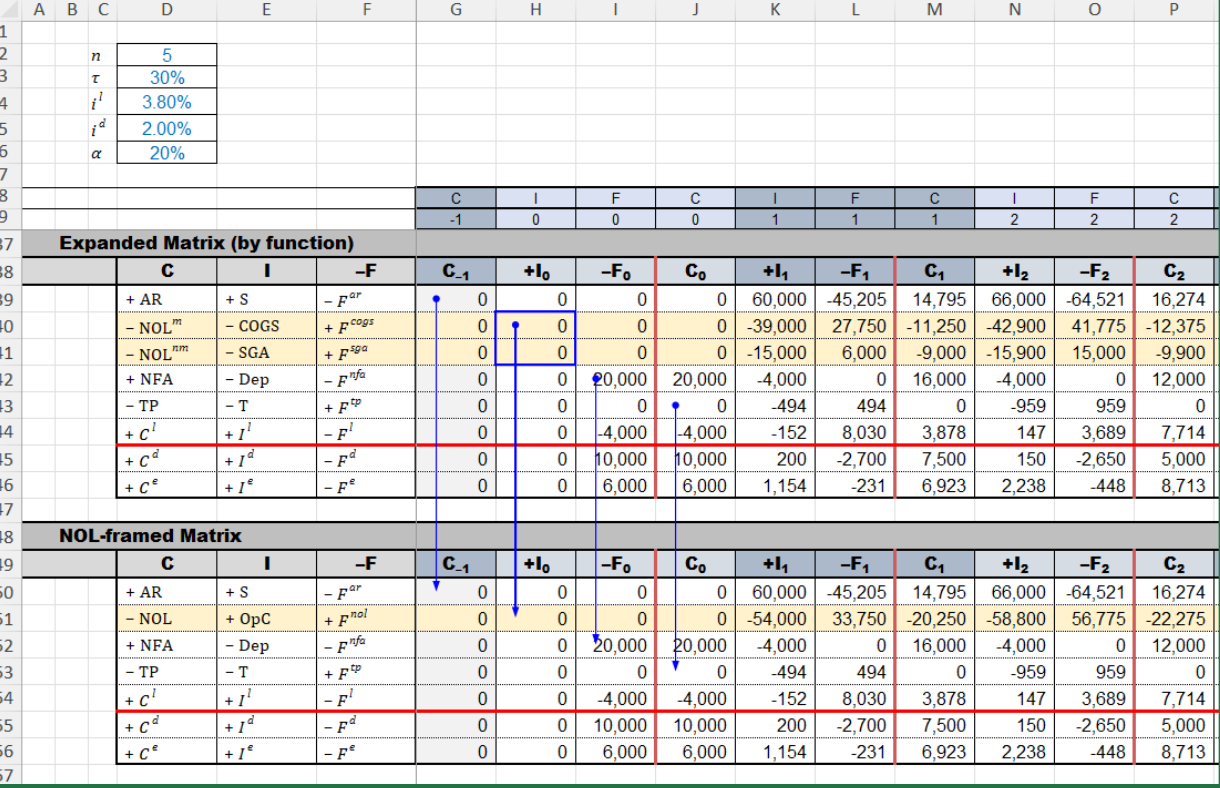
Figure 28. The strip of NOL-framed matrices (“SplitScreenStrip” sheet). The rows with the same color in the Expanded Matrix are consolidated into one row of the same color in the NOL-framed Matrix.